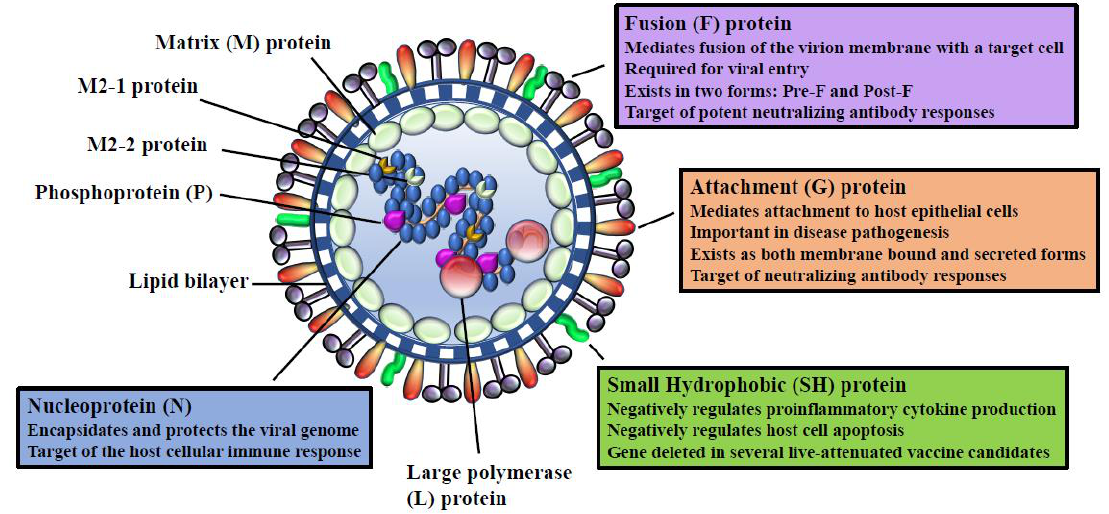
Figure 2. Schematic diagram of the RSV virion. Shown is the structure and organization of the RSV virion, emphasizing viral proteins targeted by the adaptive immune system.